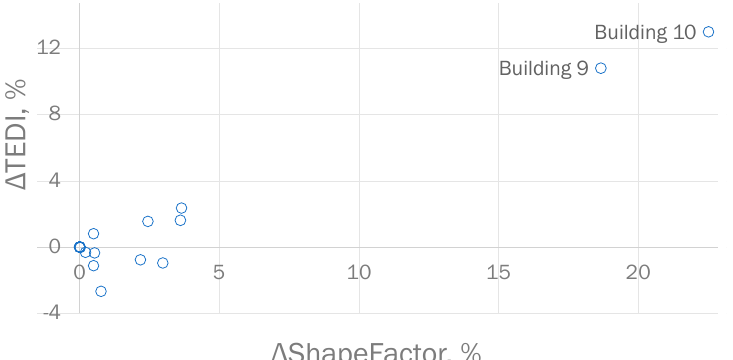
Figure 10. Relative change of shape factor and thermal energy demand intensity (TEDI) from the upgrade of the level of detail (LoD) for buildings in the Minneberg district, from LoD 1.2 to LoD 1.3 (LoD 1.2 serves as a reference).